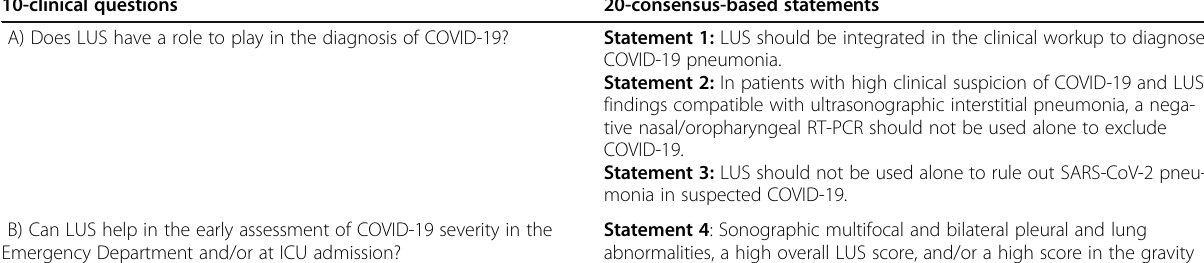
Table 1 List of clinical questions and final consensus-based